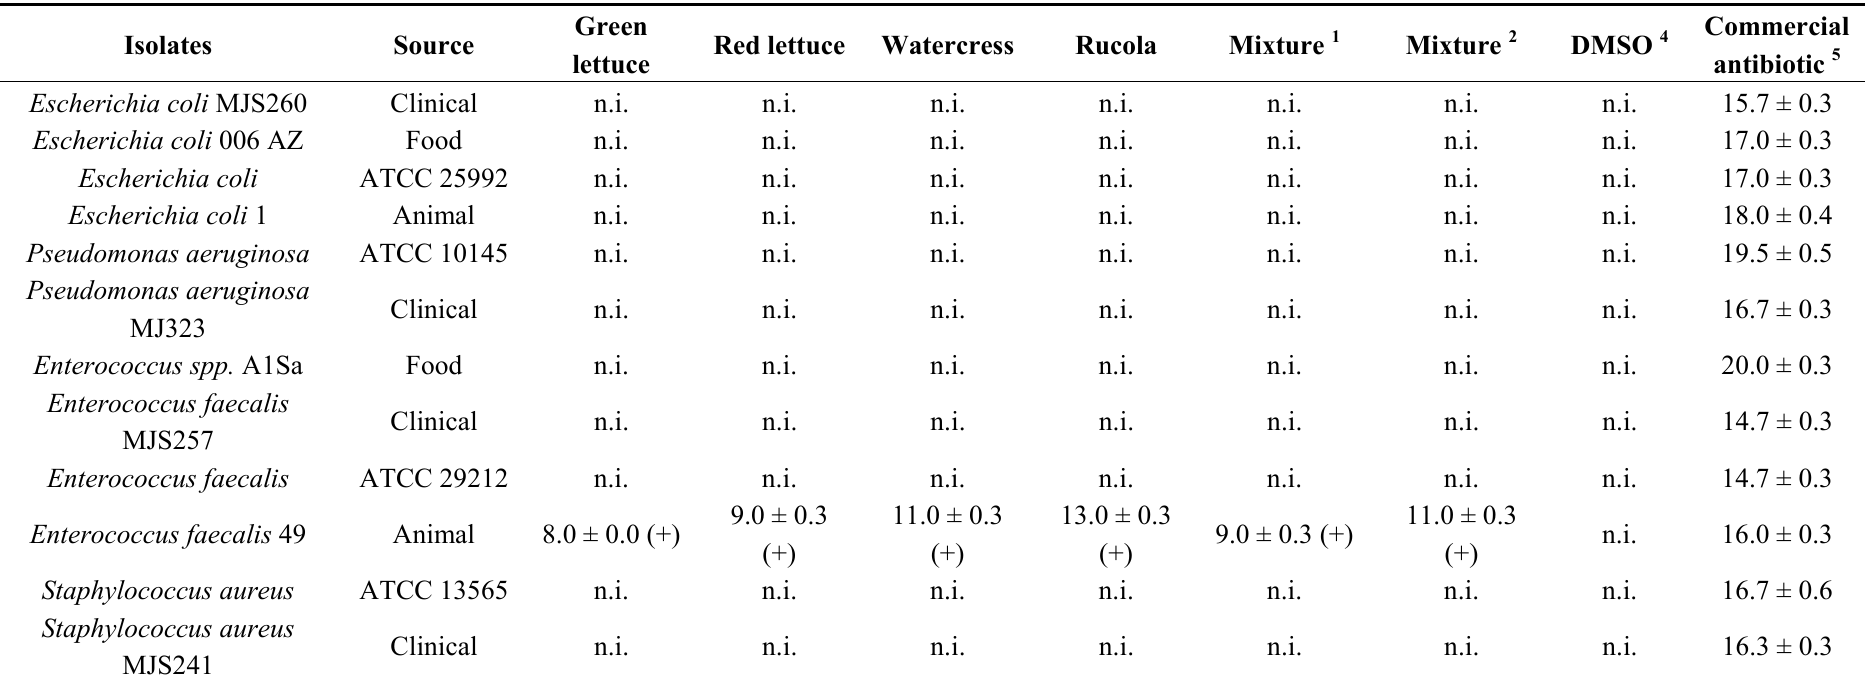
Table 6. Antimicrobial activity of hydrophilic extracts from baby-leaf salads samples at 10 mg.mL − 1 , expressed as average of diameter of inhibition zone (mm) 1,2,3